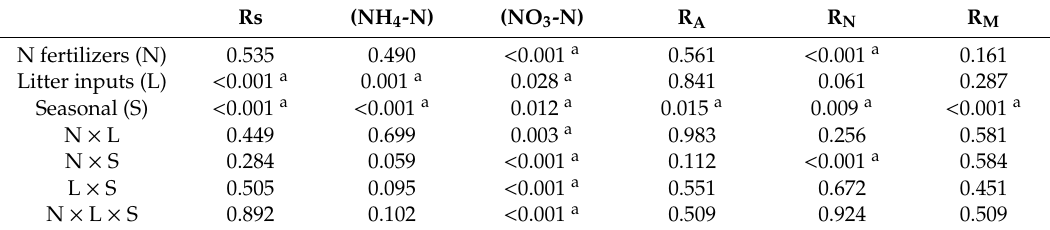
Table 2. Summary of the results ( p -value) of the three-way factorial ANOVA on the e ff ects of N fertilizers (N), litter inputs (L) and seasonal variation (S) and their interactions with soil respiration (Rs) rates, cumulative CO 2 flux (CRs), ammonium(NH 4 -N), nitrate concentration(NO 3 -N), net ammonification rates (R A ), nitrification rates (R N ), and N mineralization rates (R M ).